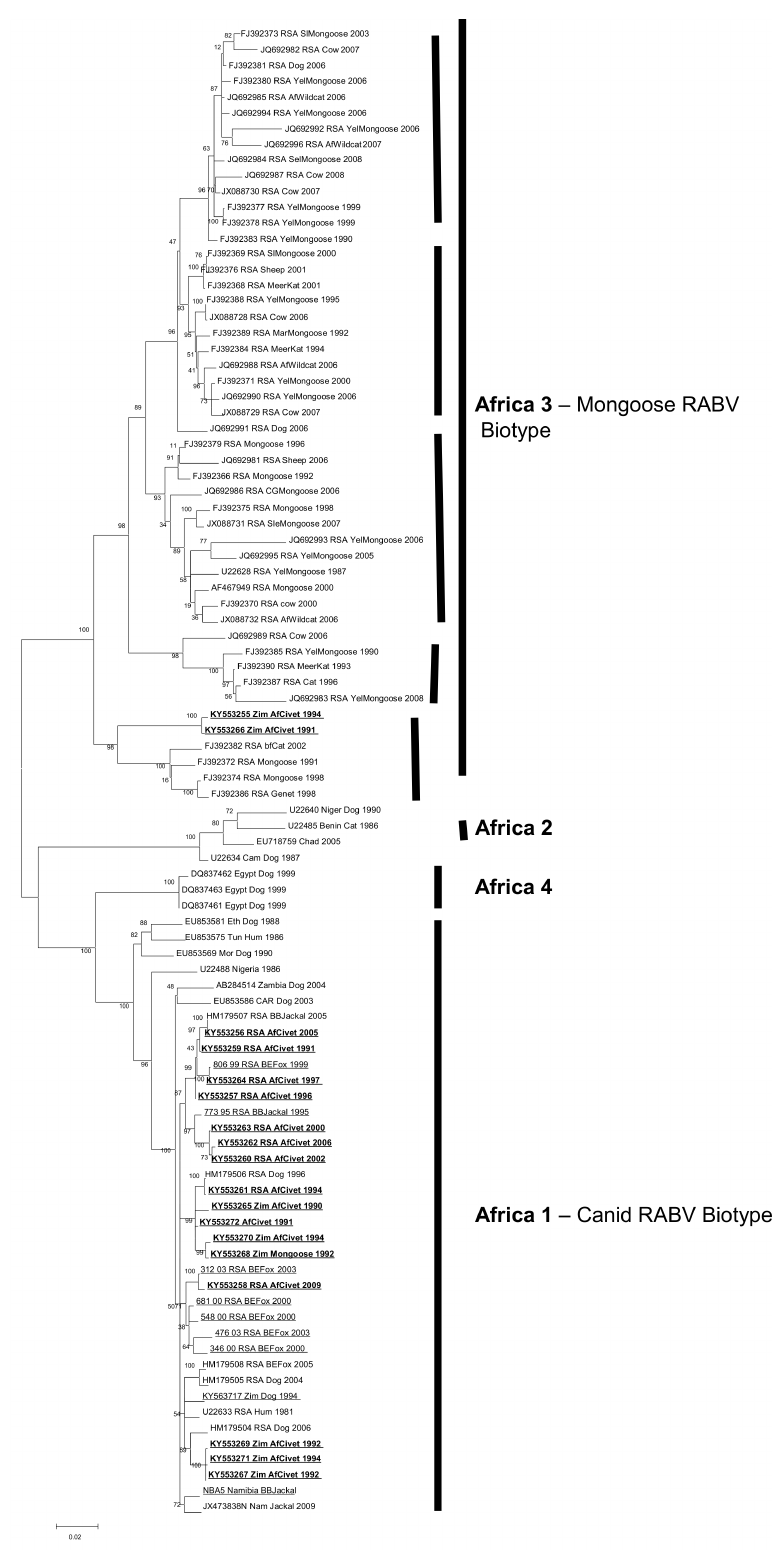
Figure 2. Maximum likelihood phylogenetic tree of complete N-gene coding sequence of representative African canid rabies virus (RABV) sequences including the African civet N-gene sequences (bold and underlined). African RABV lineages are highlighted by solid lines. The five clades within Africa 3 are also indicated by bold and vertical